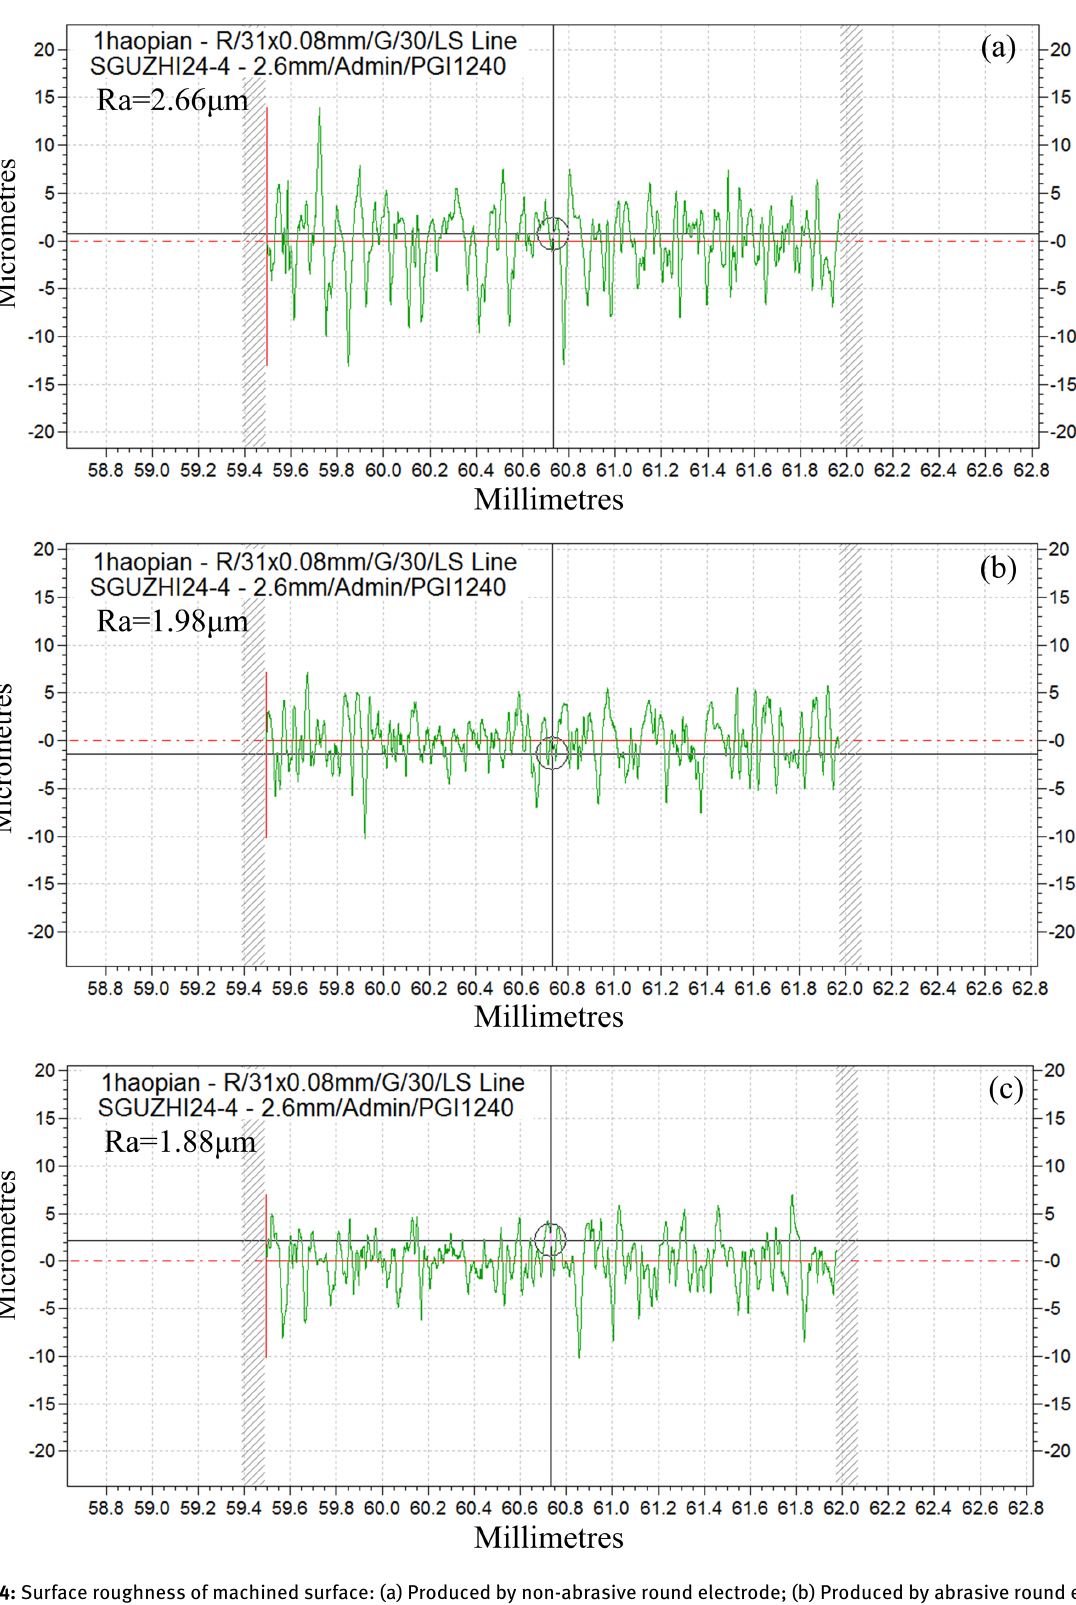
Figure 14: Surface roughness of machined surface: (a) Produced by non-abrasive round electrode; (b) Produced by abrasive round elec- trode; (c) Produced by abrasive shaped